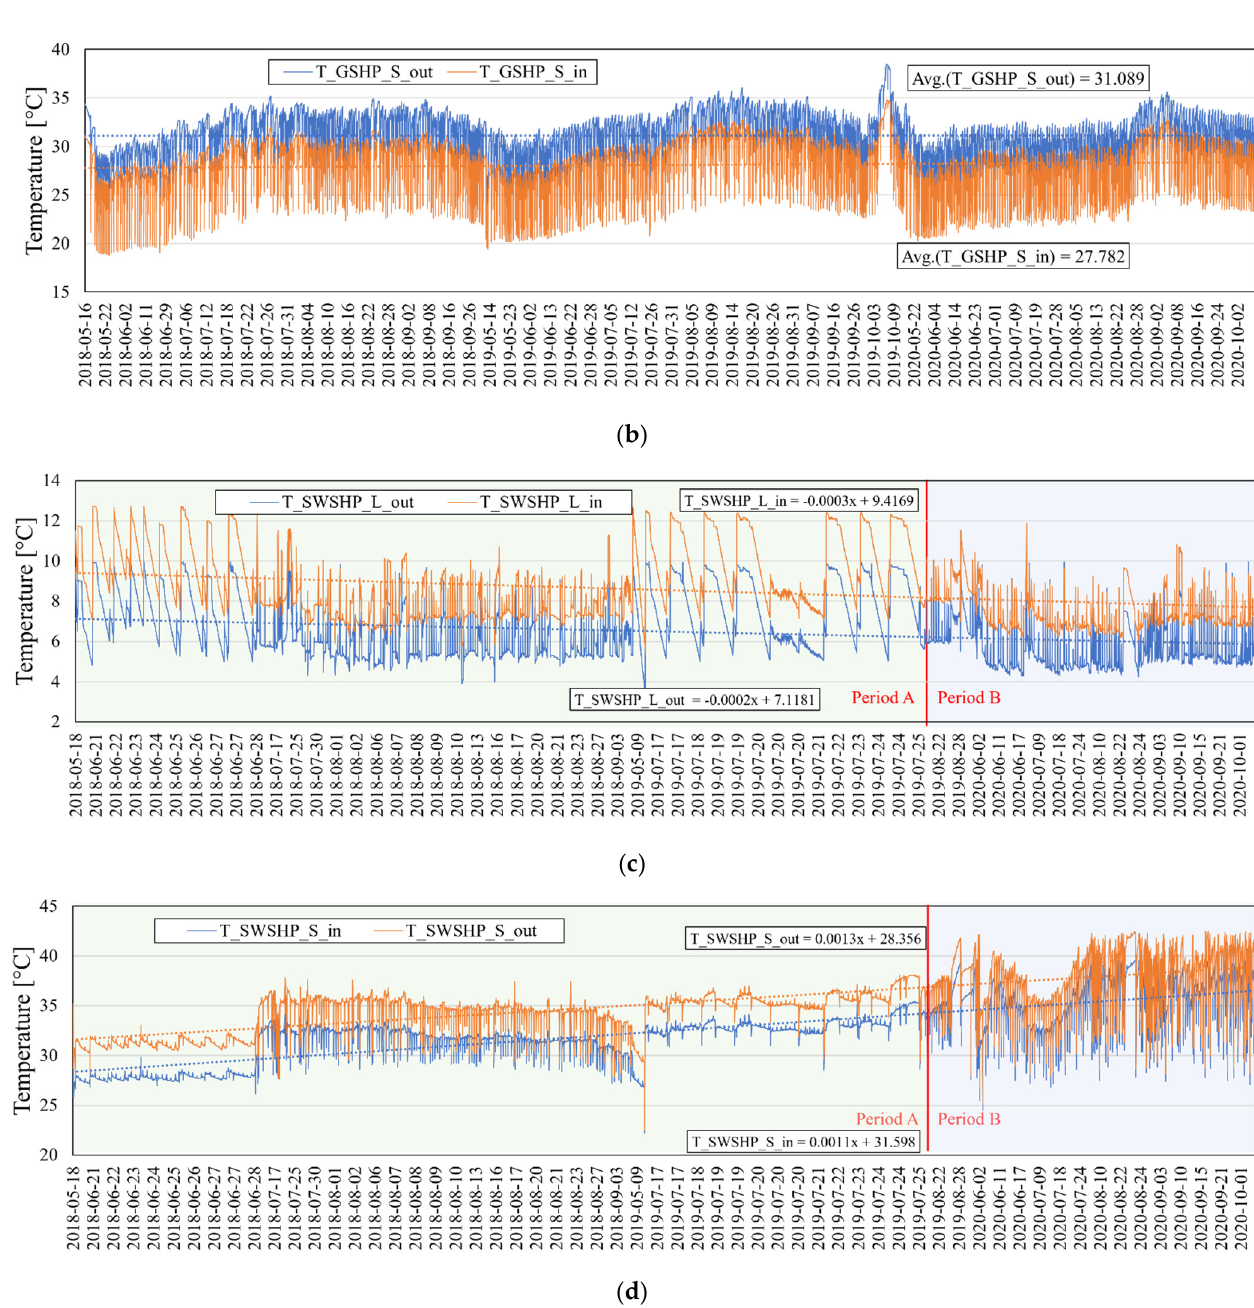
Figure 6. Thermal performance of the heat pump systems under the cooling season: ( a ) load side operation of GSHP; ( b ) source side operation of GSHP; ( c ) load side operation of SWSHP; and ( d ) source side operation of SWSHP.